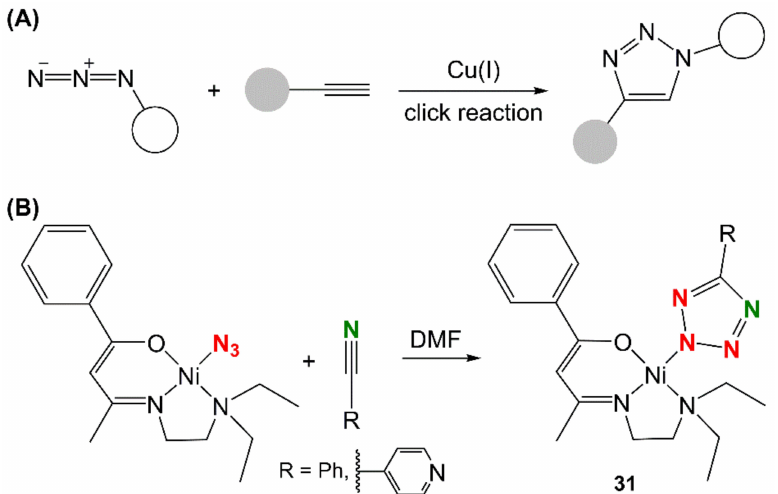
Figure 10. ( A ) The traditional copper-catalyzed azide–alkyne cycloaddition and ( B ) the general scheme of synthesis of nickel tetrazolato complexes adapted from